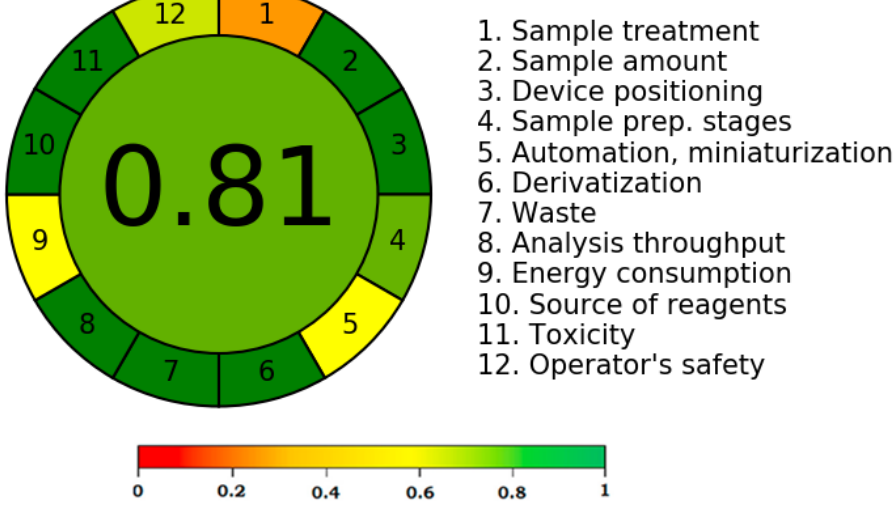
Figure 4. Analytical GREEnness (AGREE) score for the established HPLC assay of CCM determina- tion predicted using AGREE calculator.